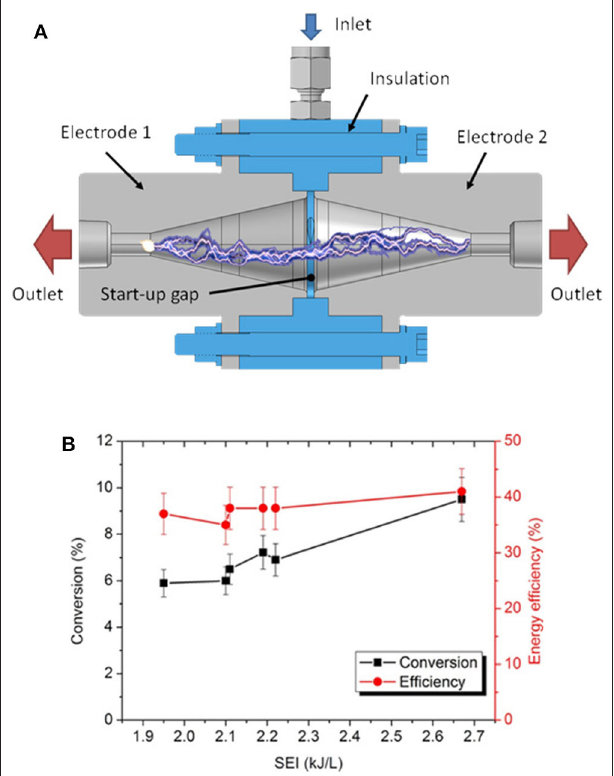
FIGURE 12 | Schematic illustration of the dual-vortex plasmatron (DVP) design (A) , and conversion and energy efficiency obtained in this setup,